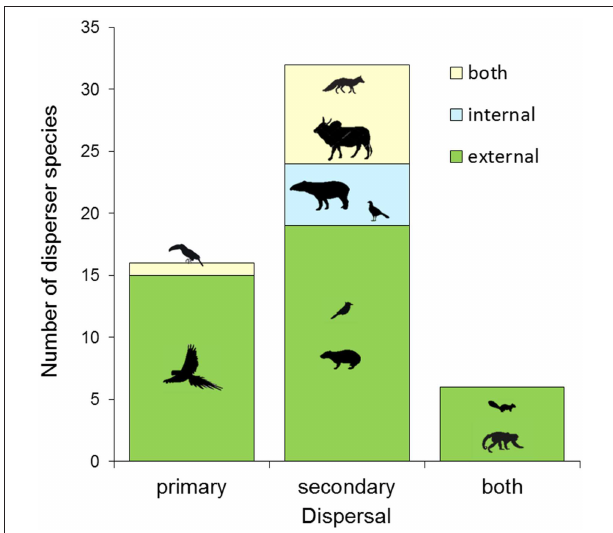
FIGURE 5 | Summary of the number of seed disperser species (pooling all palm species) according to dispersal mode (primary, secondary, or both) and mechanisms (external, internal, or both).